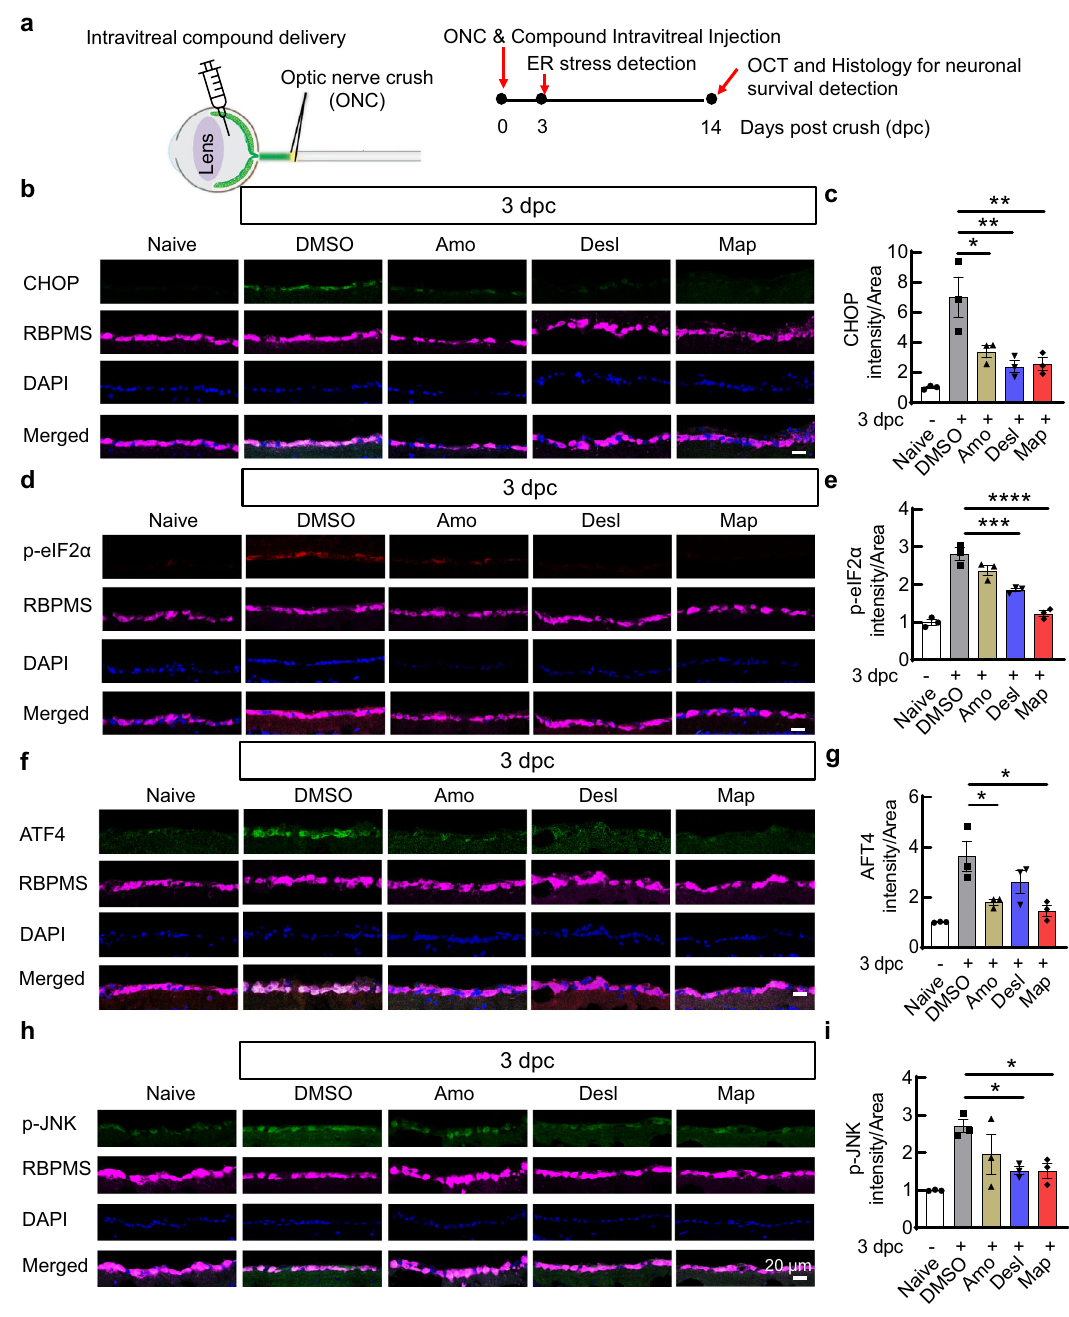
Fig.3|InvivoapplicationofthethreehitcompoundsinhibitsONC-inducedER stressinRGCs.a SchematicdepictingthemouseONCmodelandthetimelineofER stress and neuroprotection evaluation. For compound treatment, each eye received intravitreal injection with 2 µ l of 2mM test compounds once and intra- peritoneal(i.p.)injectiondaily(15mg/kg). b , d , f , h Immunohistochemistryanalysis showing the levels of CHOP ( b ), p-eIF2 α ( d ), ATF4 ( f ), and p-JNK ( h ) in GCL